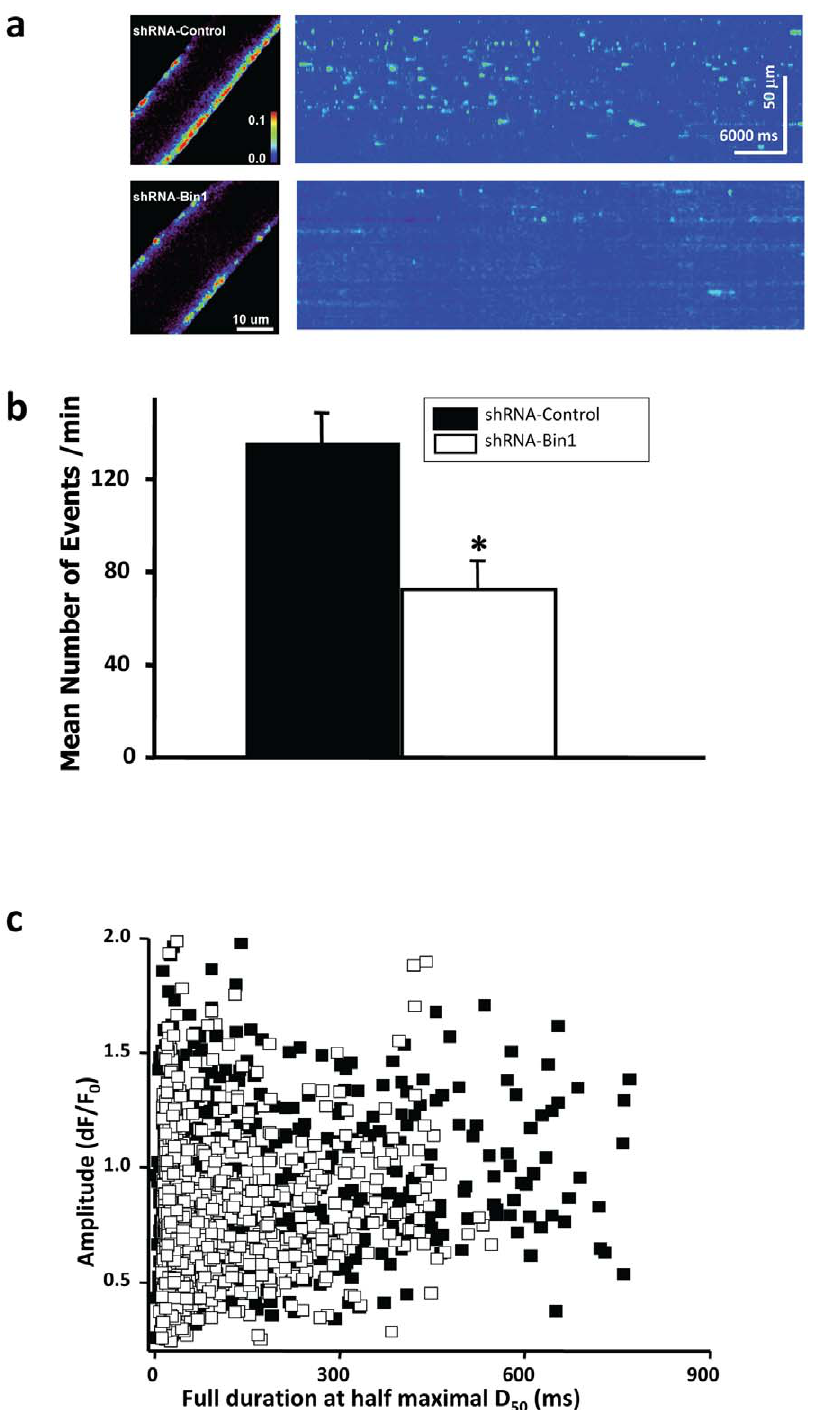
Figure 5. Defective Ca 2 + spark signaling in shRNA-Bin1 muscle. Individually isolated FDB muscle fiber that expressed either shRNA-control or shRNA-Bin1 was treated with hypotonic osmotic stress to generate a Ca 2 + sparks response. (a, left ) Representative XY images of FLuo-4 fluorescence illustrated the sub-cellular localization of Ca 2 + sparks. Images were pseudo-colored using an arbitrary scale with red appearing as the highest fluorescence signal ( inset ). shRNA-Bin1fibers (bottom) showed peripheral Ca 2 + sparks localization despite reduced Ca 2 + spark frequency when compared to shRNA-control (top). (a, right ) Representative pseudocolored x t linescan images of either shRNA-control or shRNA-Bin1 FDB fibers following osmotic stress. The frequency and amplitude of Ca 2 + appear to be lower in shRNA-Bin1 fibers. (b) shRNA-Bin1 (n=12 fibers) exhibited reduced mean Ca 2 + spark frequency per minute when compared to shRNA-control (n=12 fibers). (c) Correlation of the amplitude (dF/F 0 ) and full duration at half maximum (D 50 ) of individual Ca 2 + release events showed a population of high amplitude and long duration Ca 2 + release events in the shRNA-control fibers (filled square) that were absent in the shRNA-Bin1 group (blank square) (n=973 events for shRNA-control; 1128 for shRNA-Bin1).